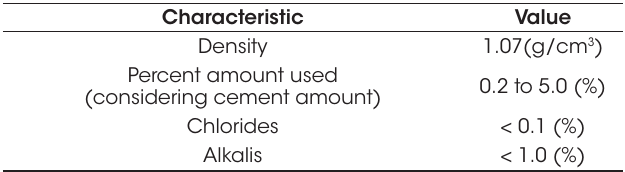
Characteristics of the admixture